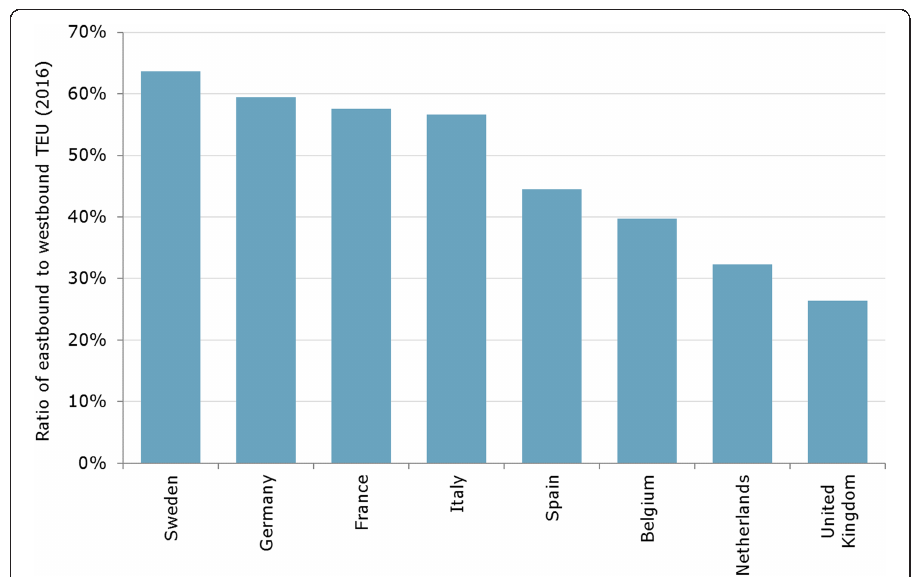
Fig. 8 Balance in loaded container flows for selected EU Member States